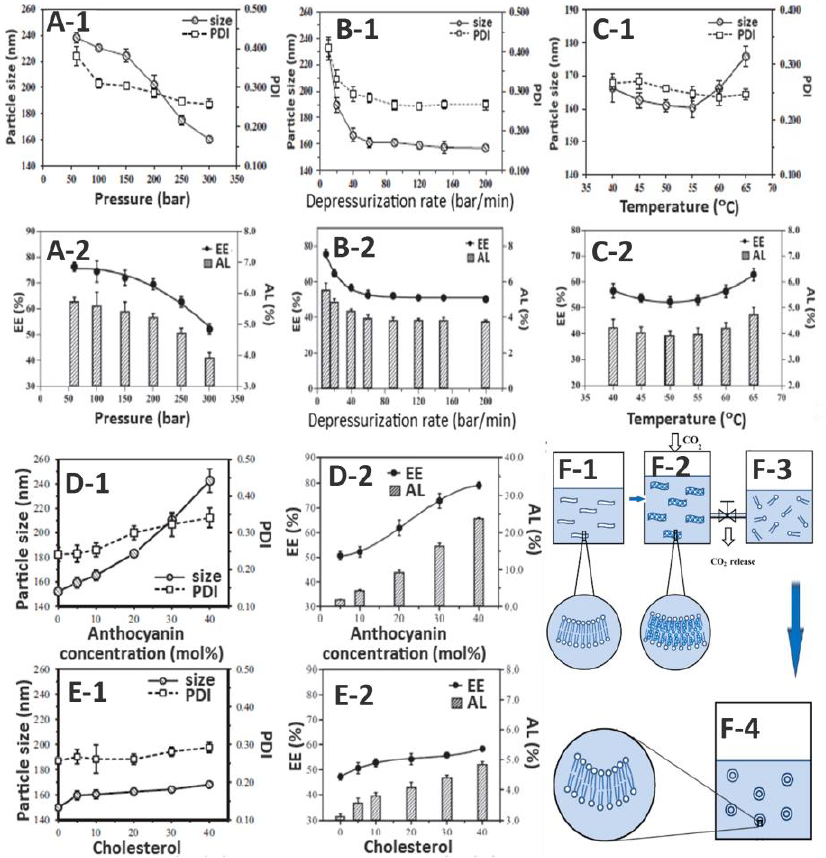
Figure 5. Anthocyanin nanoliposome characteristics as affected by several parameters involved in the supercritical carbon dioxide (SCD) preparation method and the mechanism of nanoliposome formation. Panels A-E show the effects of different SCD pressure ( A ), depressurization rate ( B ), and temperature ( C ), as well as anthocyanin ( D ) and cholesterol ( E ) concentration on particle size/polydispersity index (PDI) ( A1,B1,C-1,D-1,E1 ) and encapsulation efficiency (EE)/anthocyanin loading (AL) ( A-2,B-2,C-2,D-2,E-2 ). Panel F shows the schematic mechanism of nanoliposome by the SCD method, depicting the normal phospholipid curvatures at ambient condition ( F1 ), expanded phospholipid bilayers after pressurization and equilibration with CO 2 ( F2 ), instantaneous dispersion of discrete phospholipid molecules during depressurization and CO 2 release ( F3 ), and formation of nanoliposome vesicles through hydrophobic interactions after depressurization ( F4 ) (adapted with permission from references